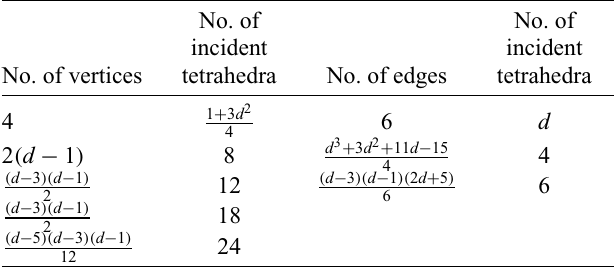
TABLE III. The lattice L 3D , which we use to define the 3D subsystem and stabilizer color codes of distance d , consists of ( d − 1 )( d + 1 )( d + 3 )/ 12 + 4 vertices, ( d − 1 )( 7 d 2 + 10 d +